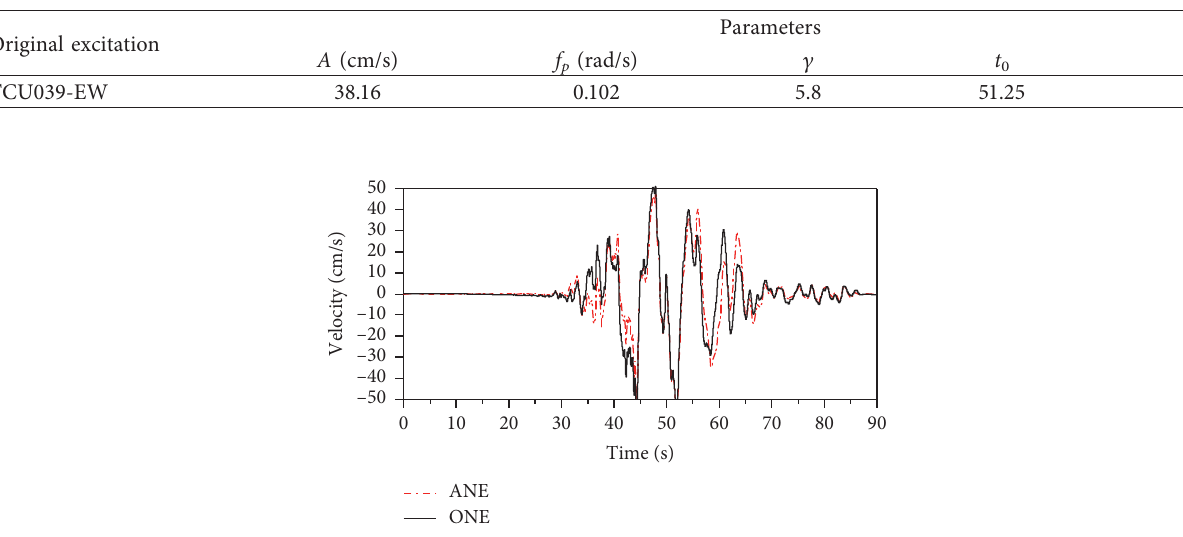
Figure 6: Velocity time-history curves of the ANE record and the ONE record.